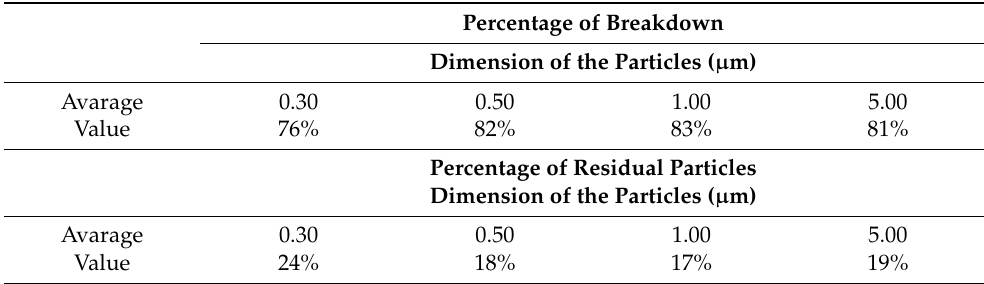
Table 2. Analysis of particles during activity S with PAC off and on.